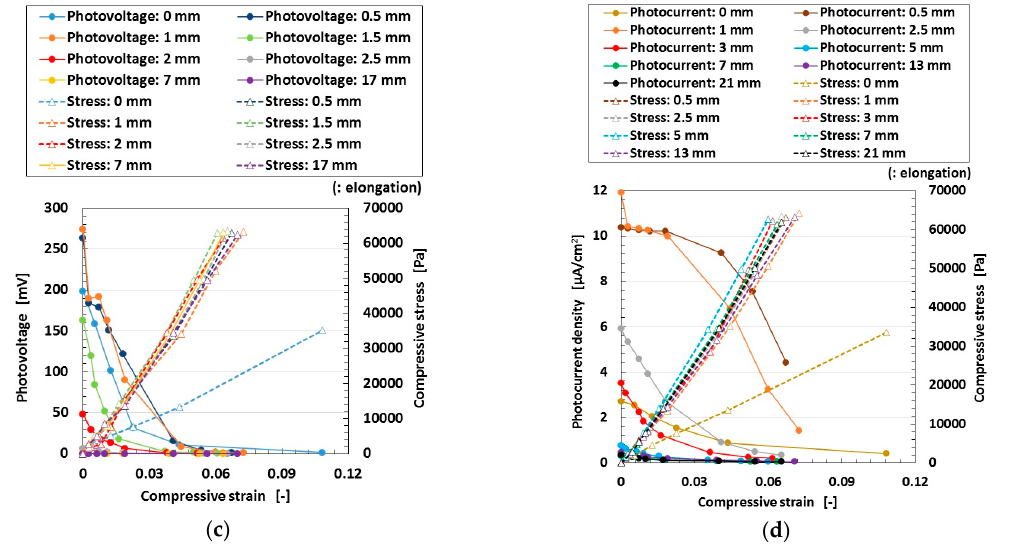
Figure 13. Changes in the effect of compression on the built-in electricity and photoelectricity under ultraviolet irradiation: ( a , b ) represent the built-in electricity; ( c , d ) represent the photo-electricity; ( a , c ) are voltage values; ( b , d ) are electric current values for wet-type MCF rubber solar cell electrolytically polymerized under a magnetic field with Ruthenium complexes dye and electrolyte KI + I 2 .